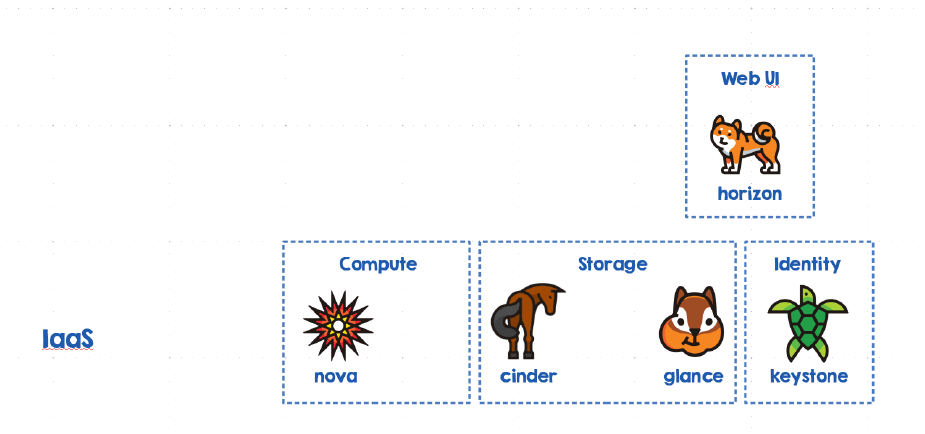
Figure 2. Initial service o ff